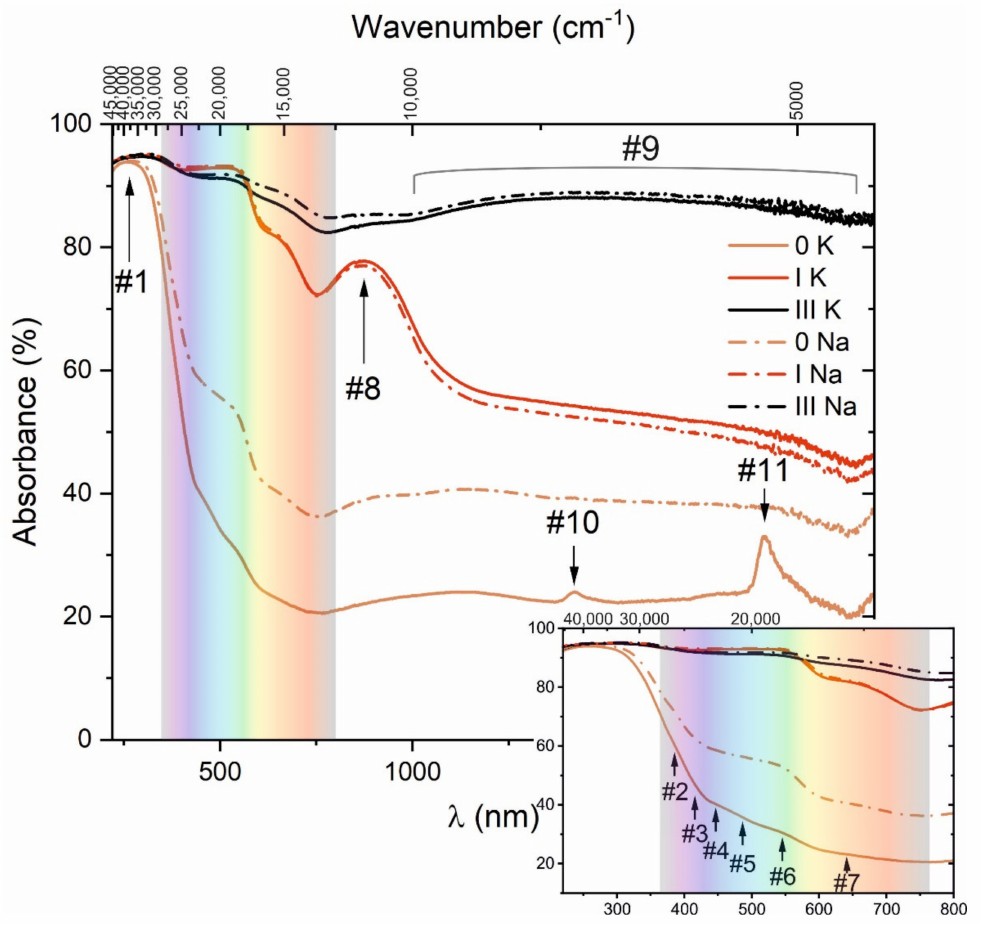
Figure 7. Optical absorbance spectra of selected samples after firing: undoped (0 K, 0 Na), doped with Fe 2 O 3 (I K, I Na), and doped with both Fe 2 O 3 and TiO 2 (III K, III